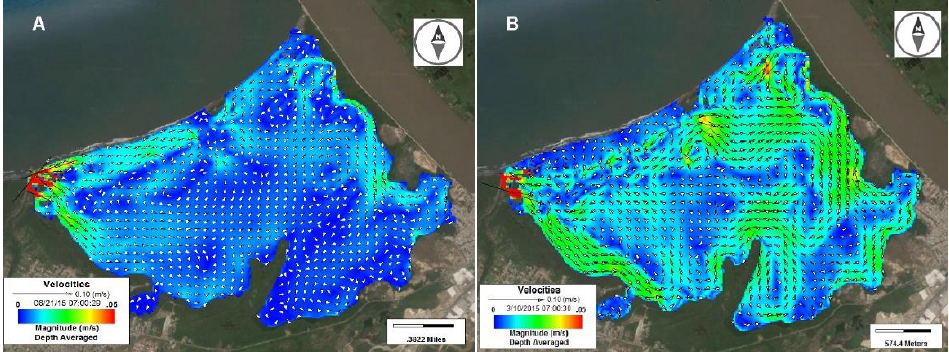
Fig. 4: Hydrodynamics simulation for Mallorquín Lagoon. A) Transition Period. B) Wet season.